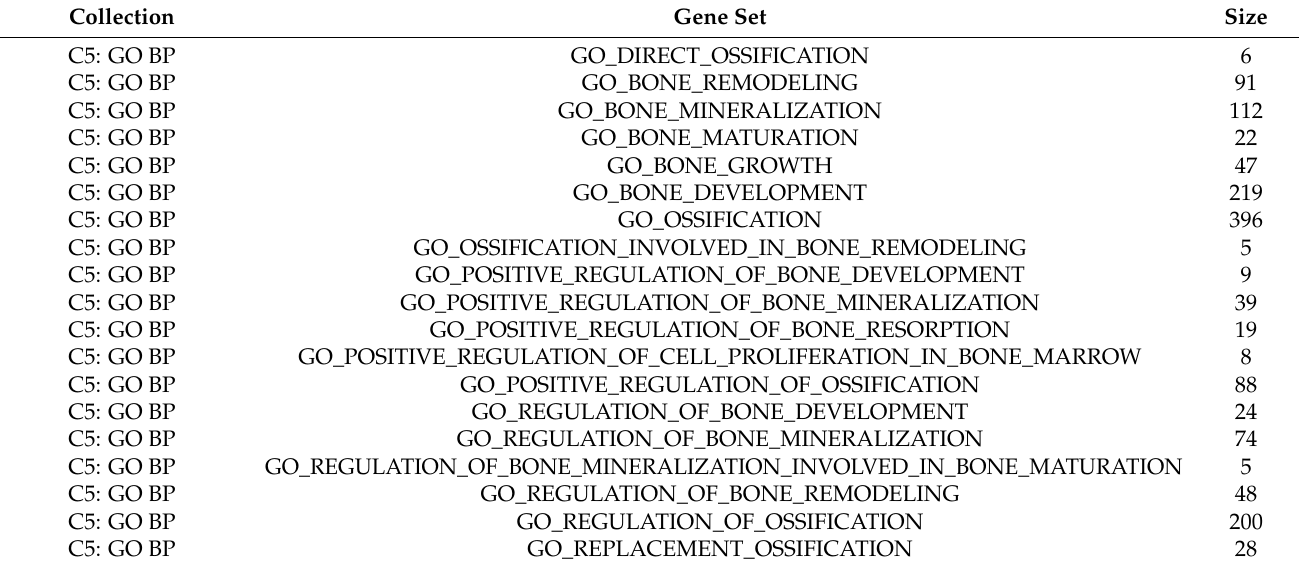
Table A2. Full list of self-defined osteogenesis-related gene sets collection.